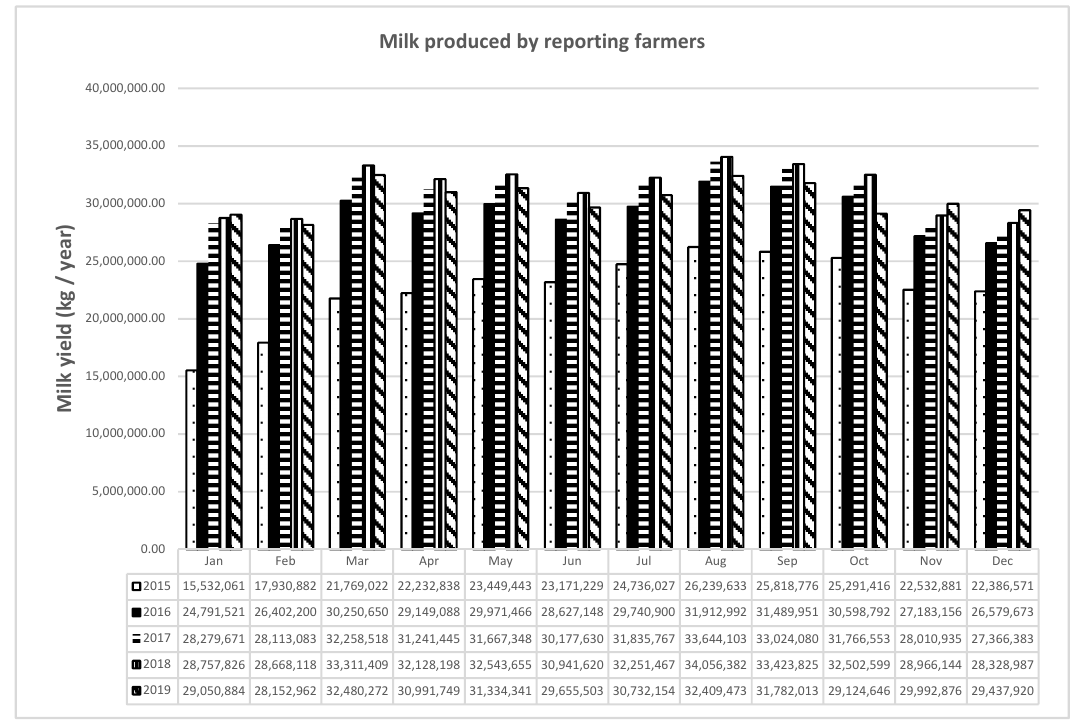
Figure 4. Average milk production per month.